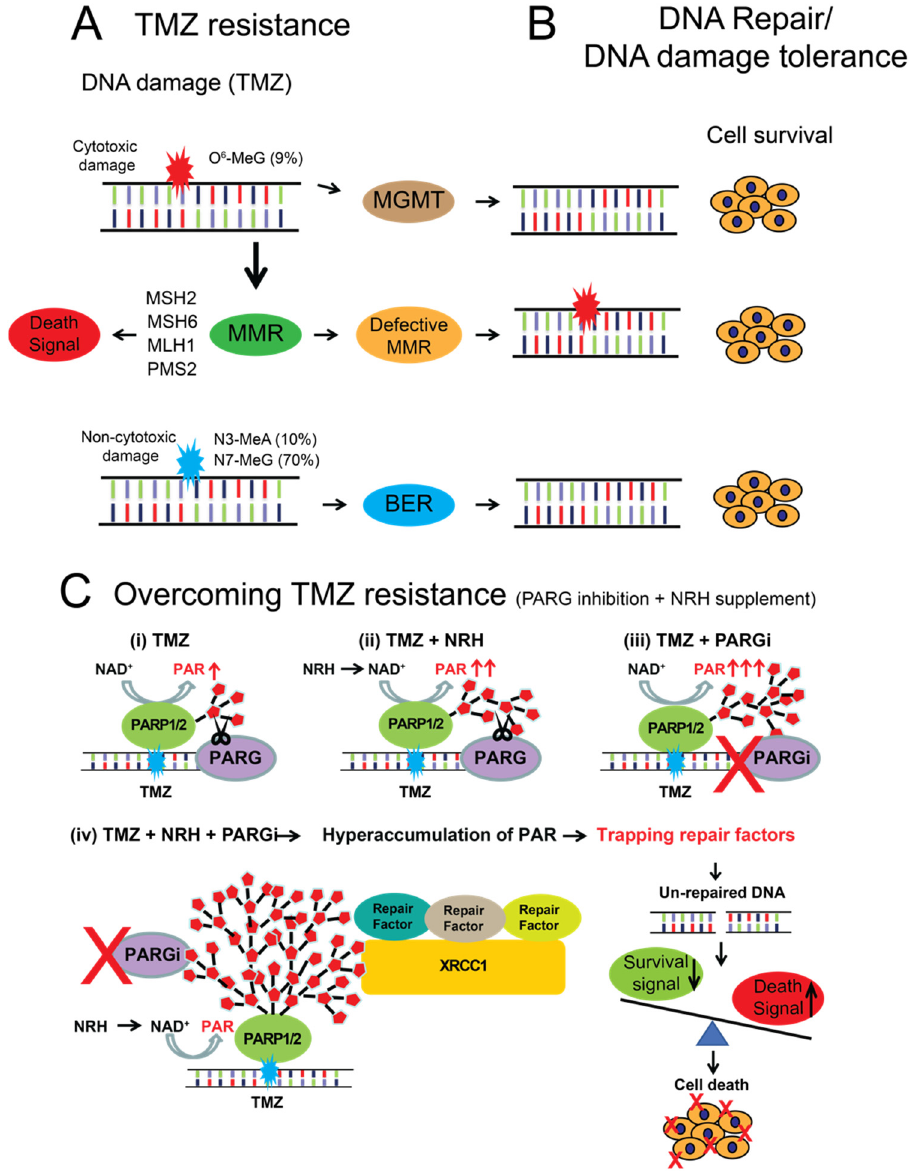
Figure 6. Proposed model of TMZ resistance mechanisms that can be overcome by co-treatment with NRH and PARGi. ( A ) TMZ generates multiple DNA lesions, including O 6 -methylguanine (O 6 -MeG, ~9%), N7-methylguanine (N7-MeG, >70%), and N3-methyladenine (N3-MeA, ~10%); ( B ) The O 6 -MeG DNA lesion can be directly repaired by MGMT leading to TMZ resistance. If the O 6 -MeG/T mis-pair is acted upon by proteins of the MMR pathway, this leads to cell death. However, when the MMR pathway is defective, due to loss of expression or mutations in genes of the MMR pathway, then the O 6 -MeG/T mis-pair is tolerated and leads to TMZ resistance. Finally, the N7-MeG or N3-MeA DNA lesions are repaired by proteins of the BER pathway; ( C ) (i) TMZ induces PARP1/PARP2 activation, inducing the synthesis of PAR; (ii) NRH increases NAD + , which enhances PARP1/PARP2 activation and promotes an increase in PAR formation; (iii) Inhibition of PARG blocks degradation of PAR; (iv) Co-treatment of TMZ, NRH, and PARGi results in the hyperaccumulation of PAR, trapping DNA repair factors and leading to an increase in unrepaired DNA damage, a decrease in cell survival signaling, and an increase in cell death